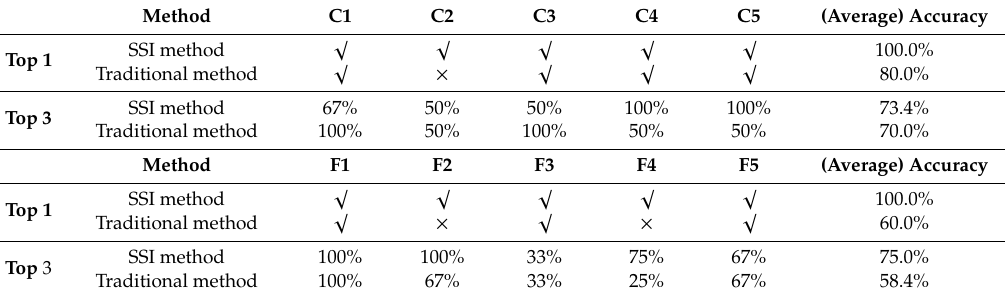
Table 14. Pigment identification accuracy of the two